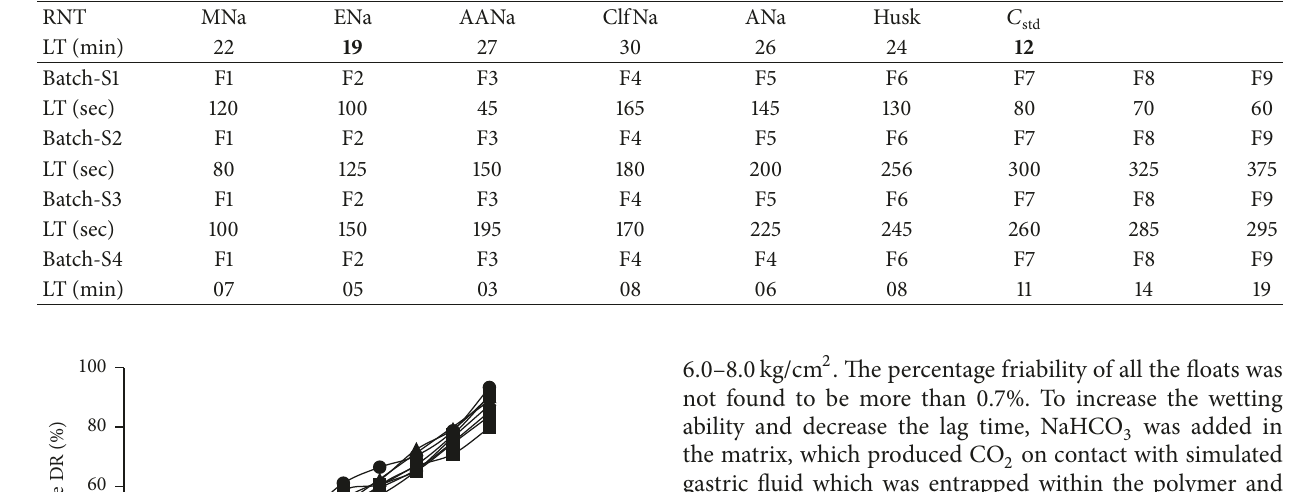
Table 4: Lag time (LT) of all batches.